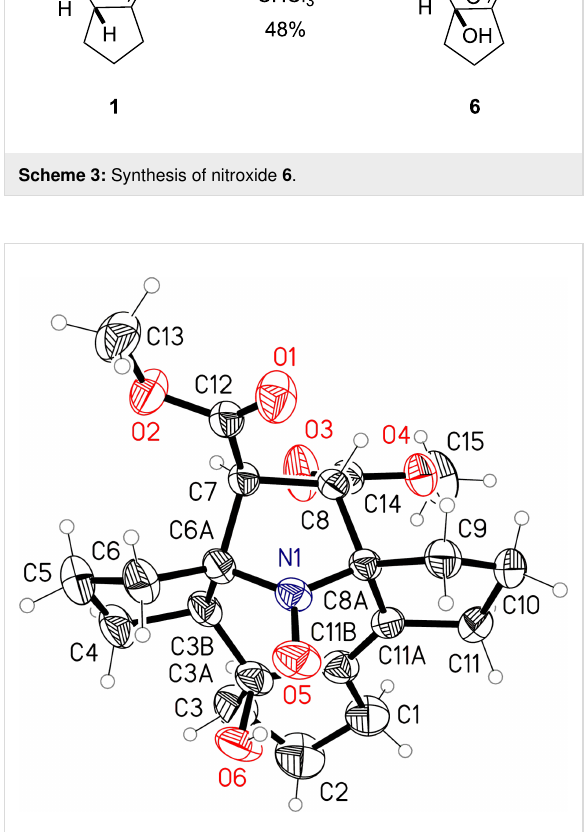
Figure 4: X-ray structure of compound 6 (one of the two enantiomers present in the